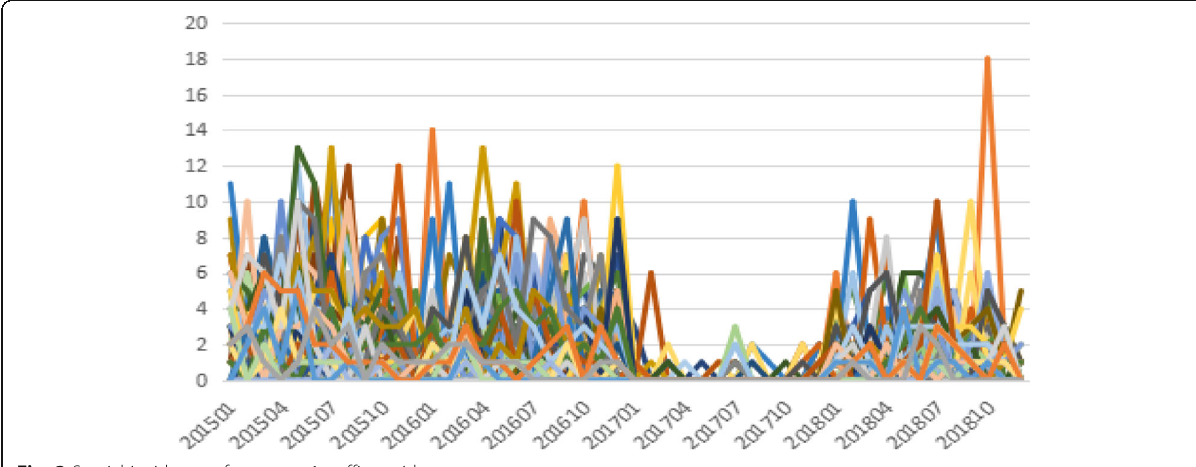
Fig. 3 Spatial incidence of category 1 traffic